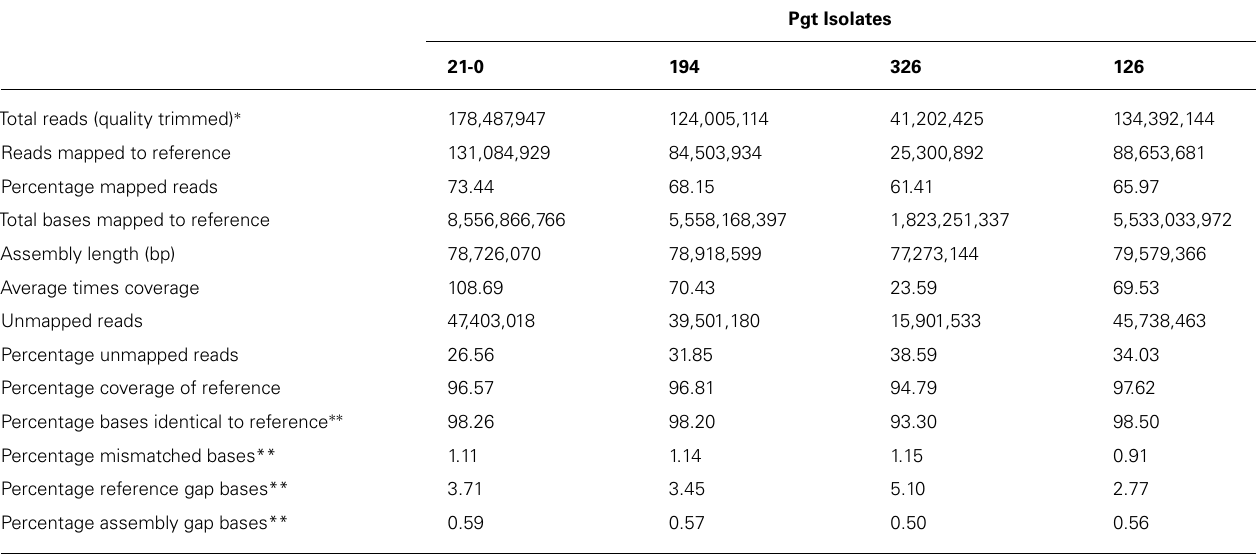
Table 2 | Mapping of Illumina DNA reads fromAustralian Pgt isolates against p7a reference.